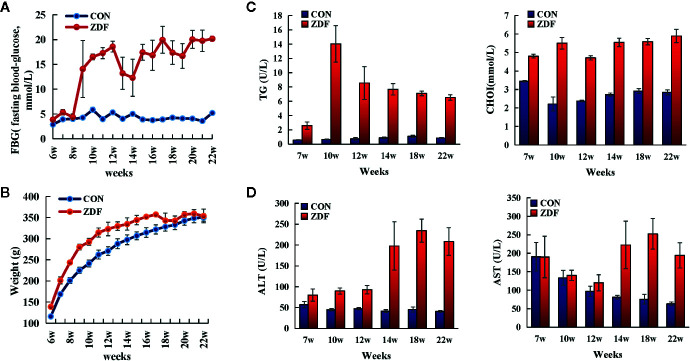
Clinical indices revealing the progression of T2DM in Zucker diabetic fatty (ZDF) rats. Physiological and biochemical indices, including body weight (A), fasting blood glucose (B), serum lipid metabolism indexes (C) and hepatic function indexes (D), were constantly monitored in ZDF and healthy ZCL rats from weeks 6 to 22. Five rats were present within each group, and values indicate mean ± SEM. TG, triglycerides; CHOL, total cholesterol; ALT, glutamic pyruvic transaminase; AST, glutamic oxaloacetic transaminase.